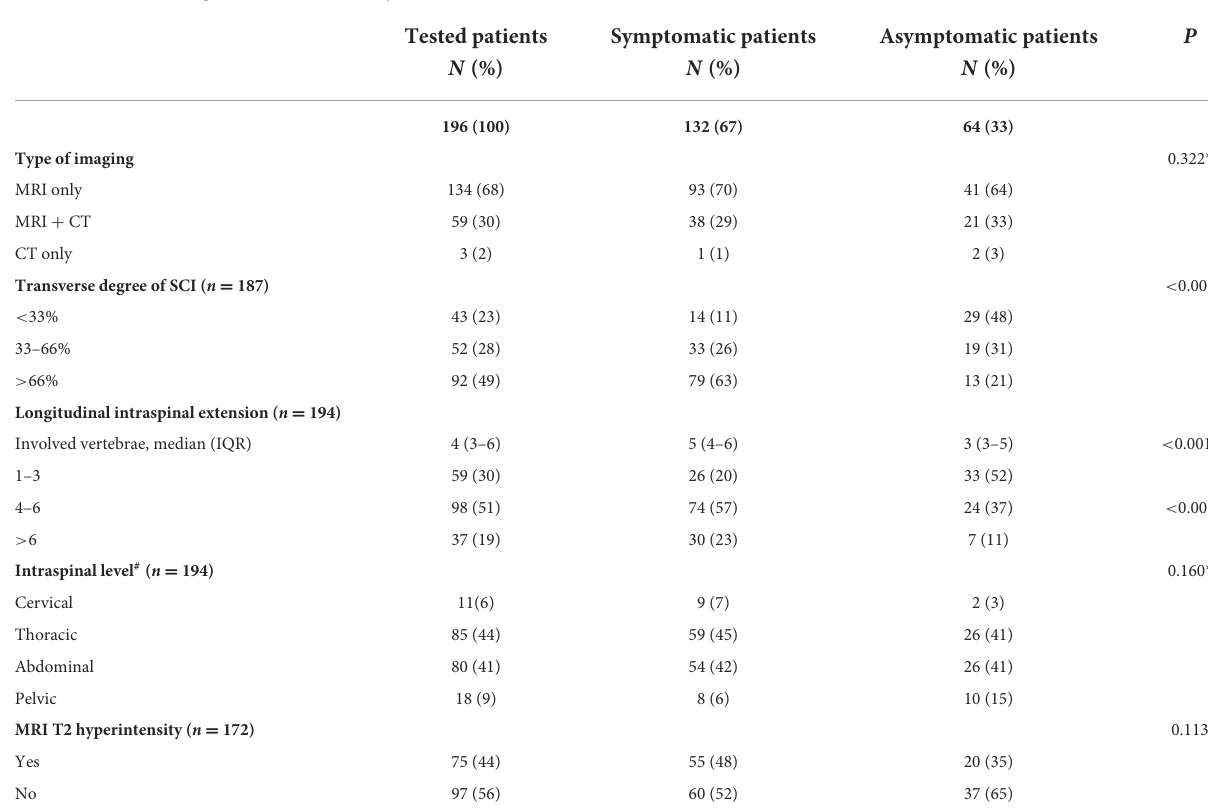
TABLE 3 Neuroradiologic features of NB-SCI